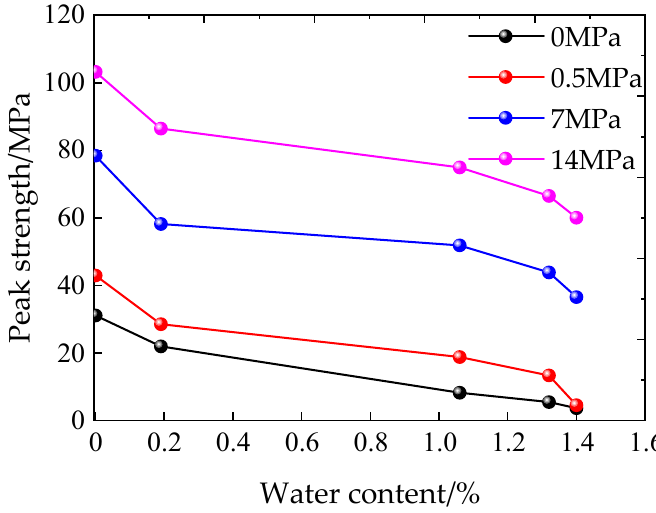
Figure 6. Relationship between different water contents and peak strength.